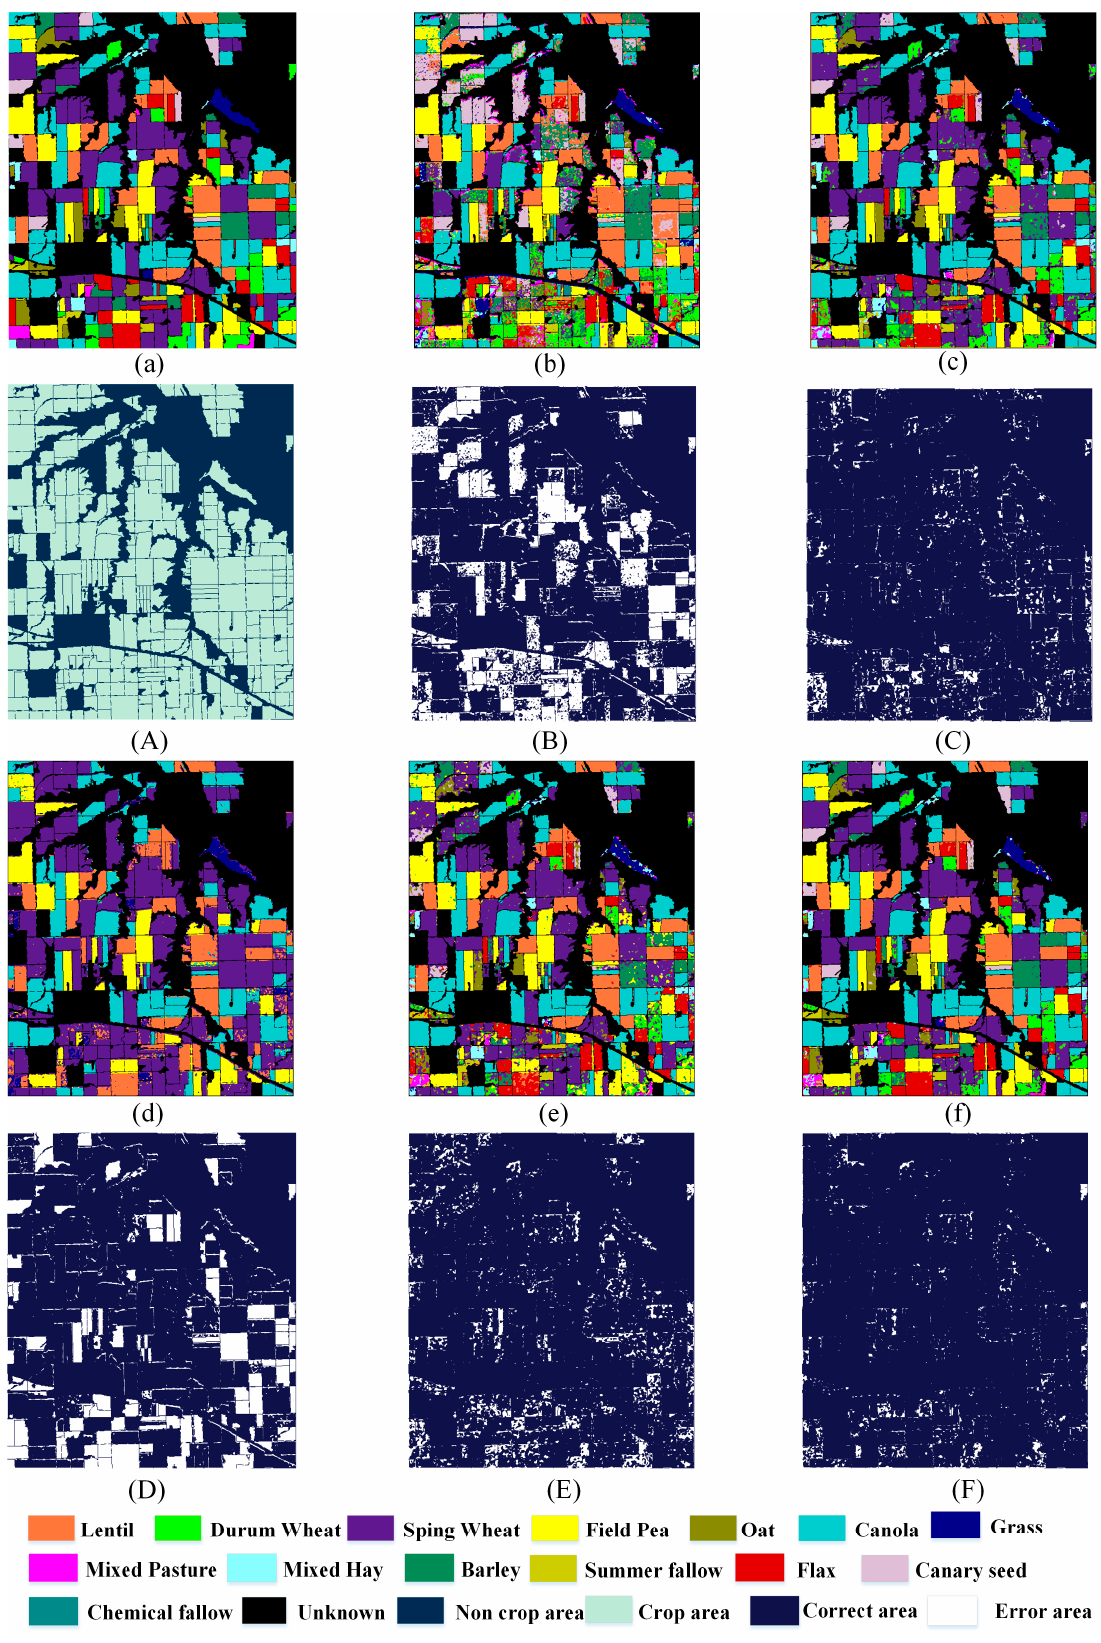
Figure 14. Classification results and ground truth map for the Indian Head site: ( a ) ground truth map, ( A ) crop area, ( b ) complex Wishart classifier, ( c ) Chen + CNN, ( d ) long short-term memory (LSTM), ( e ) locally linear embodied (LLE) + CNN, and ( f ) S-SAE + CNN. ( B – F ) are the error maps of ( b – f ).